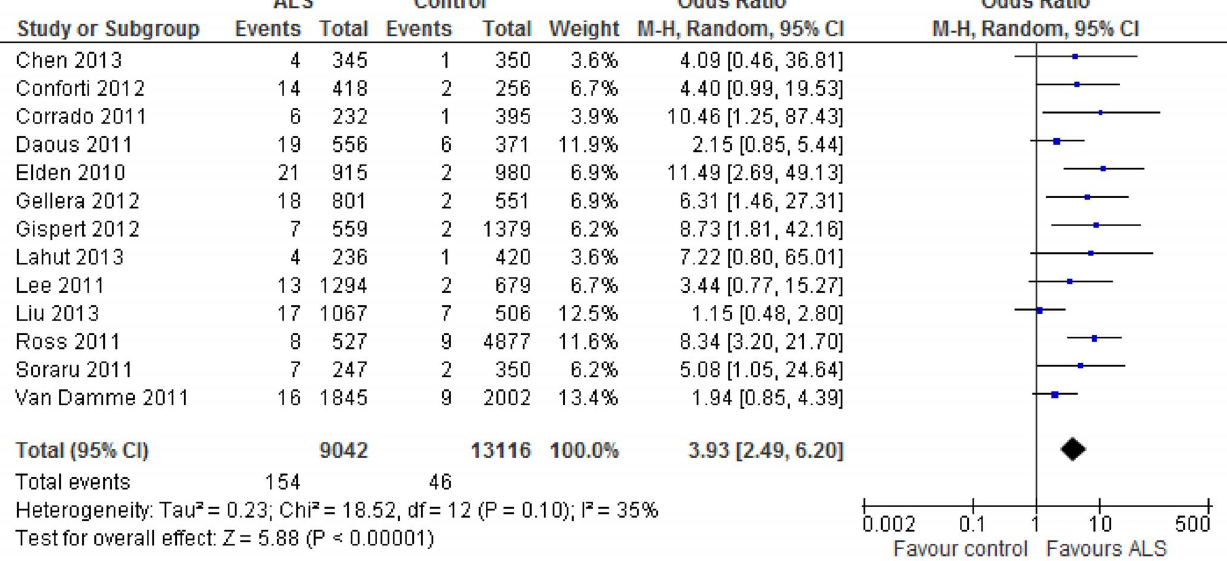
Figure 3. The presence of intermediate CAG 30–33 repeats in the ATXN2 gene is associated with ALS . The data of intermediate CAG 30– 33 repeats in ATXN2 were extracted from 13 included studies and the OR of intermediate CAG repeat among ALS and control subjects was